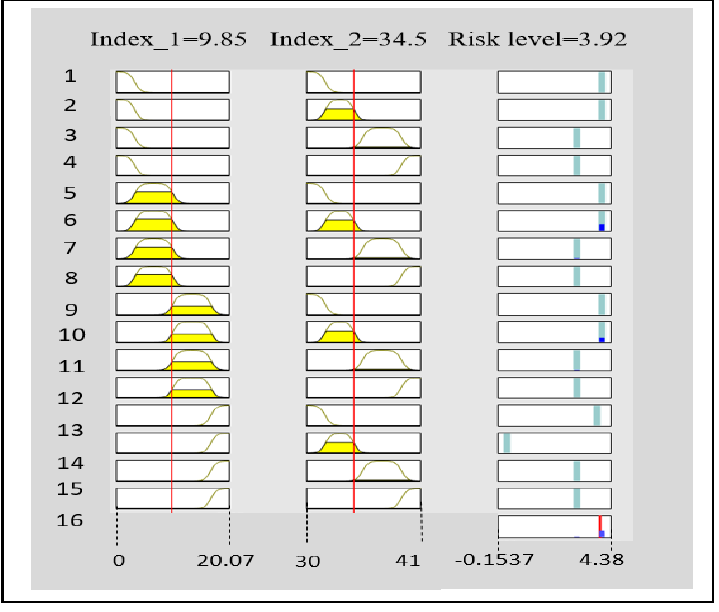
Figure 12. Trained main ANFIS of indexes and output of risk (Matlab’s rule viewer).